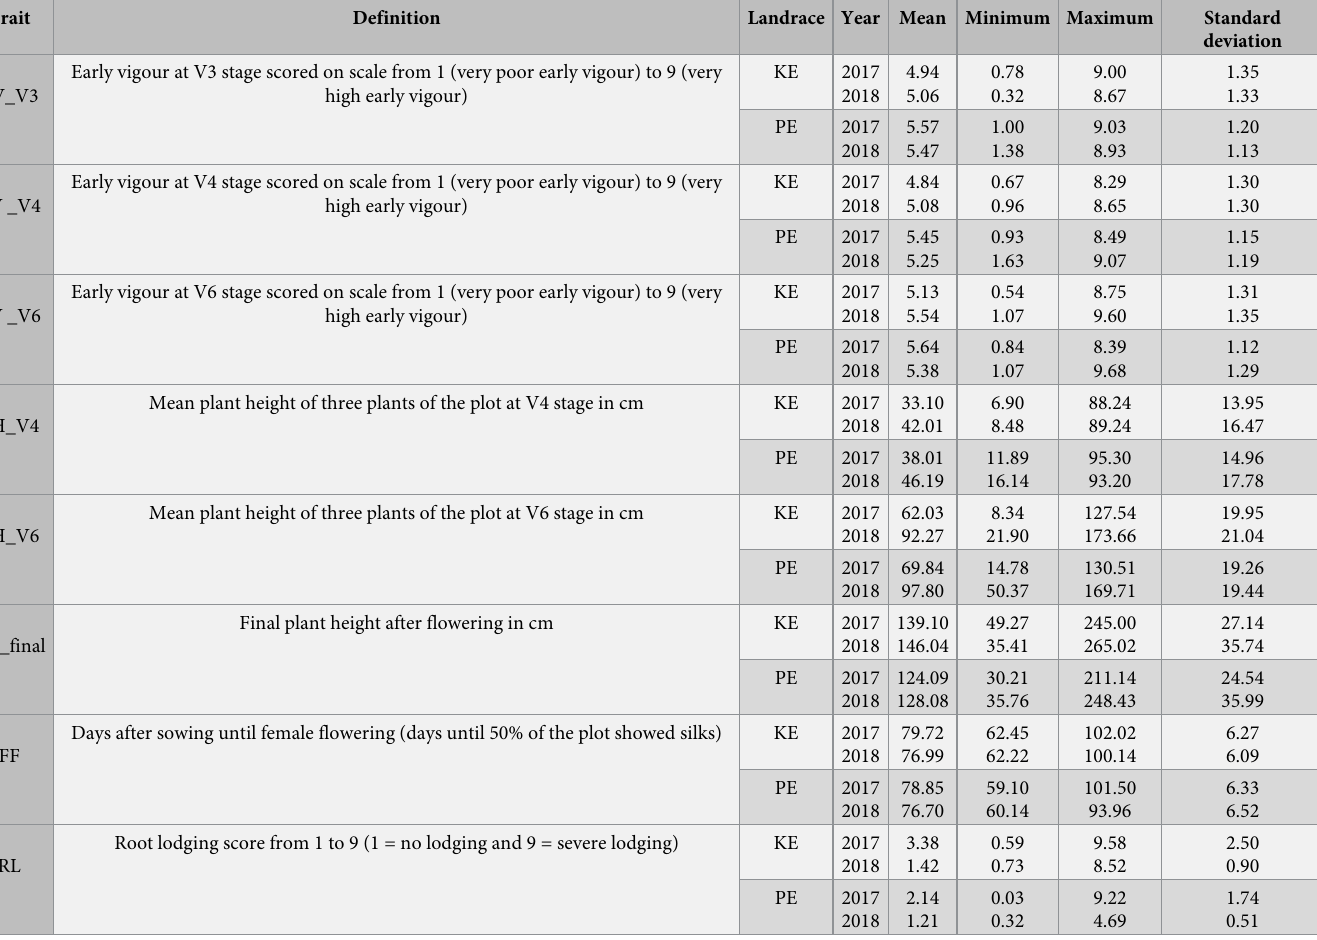
Table 1. Phenotypic trait description and the mean, minimum, maximum and standard deviation of the BLUEs for each phenotypic trait in KE and PE landraces in the years 2017 and 2018. Trait